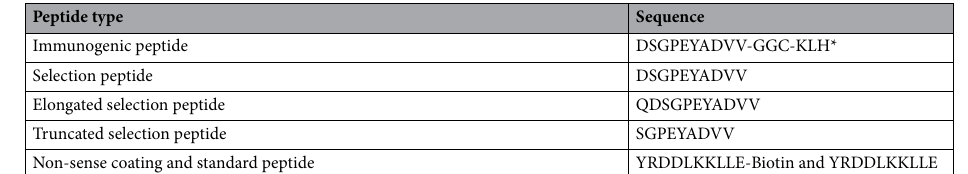
Table 1. Sequences of the synthetic peptides used for monoclonal antibody production, assay development and validation. *Keyhole Limpet Hemocyanin.